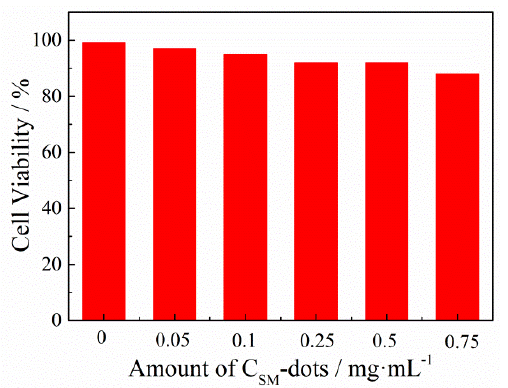
Figure 4. HeLa cell viability after incubation with different concentrations of C SM -dots for 24 h.